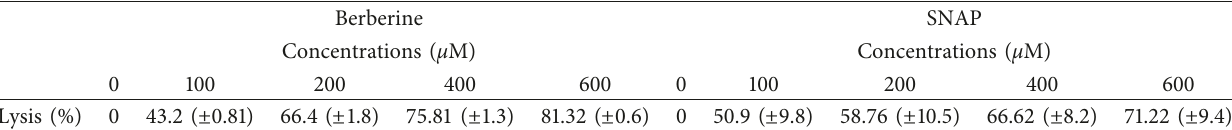
Table 2: Cytotoxic activity of berberine and SNAP alone against the MCF-7 tumour cell line.